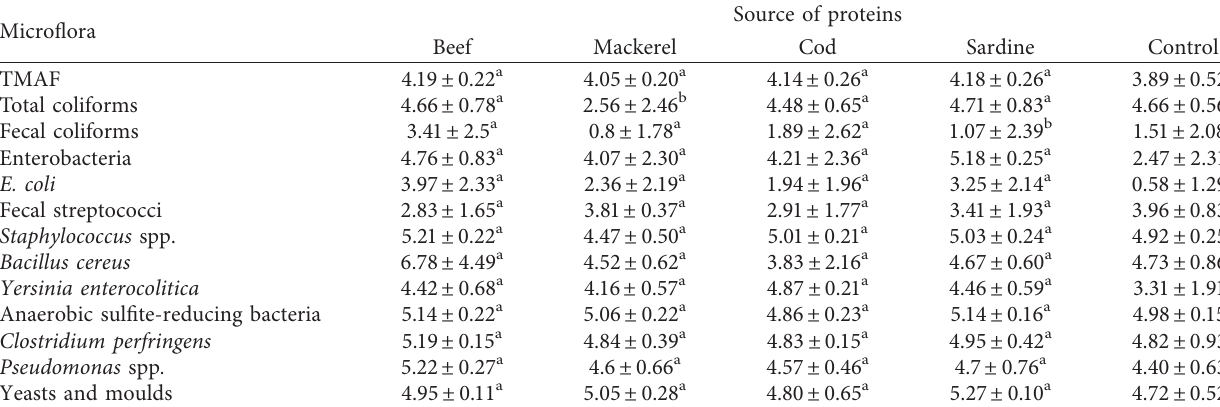
Table 2: Distribution of the means microbial loads (Log CFU/g) of the samples of Egusi pudding according to the protein sources. Microflora